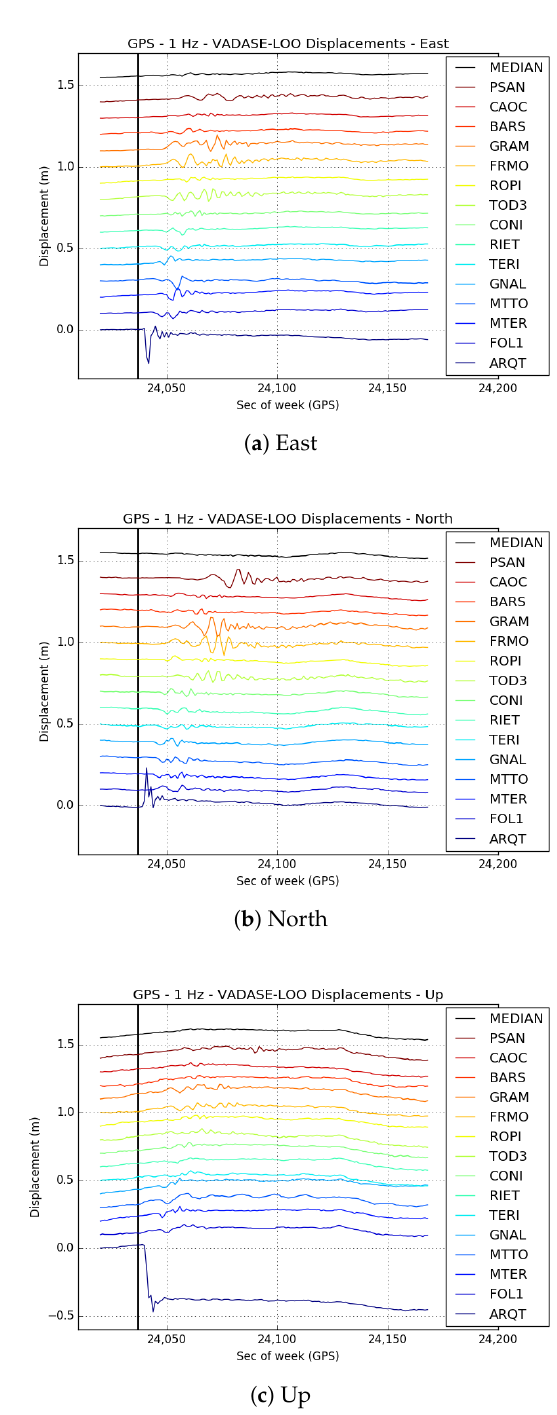
Figure 3. Estimated displacements by VADASE-LOO for the 150-s interval across the 30 October 2016 main shock (GPS